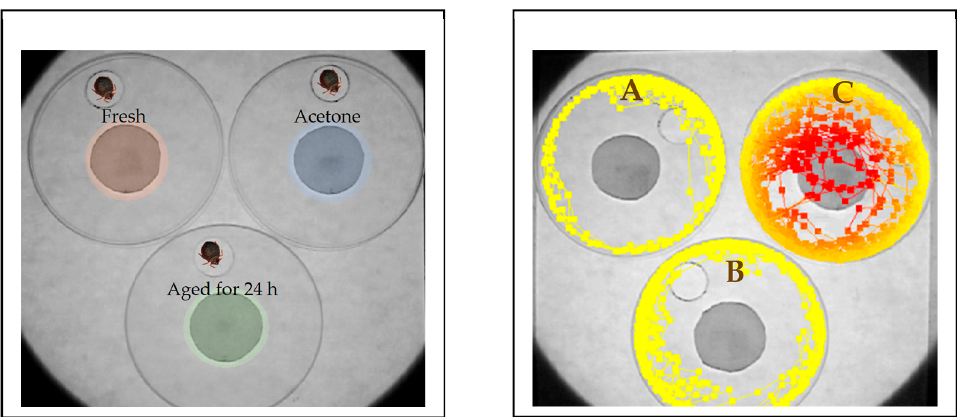
Figure 1. Left, arrangement of experimental arenas for simultaneous tracking of responses from individual bed bugs to essential oil constituents. Right, an example of tracks of bed bugs avoiding fresh residues ( A ), or residues aged for 24 h ( B ). ( C ) is tracks of a bed bug interacting with a control arena (acetone-treated area); red tracks represent approximation of the bed bug to the acetone-treated area, indicating that the insect did not exhibit avoidance behavior.